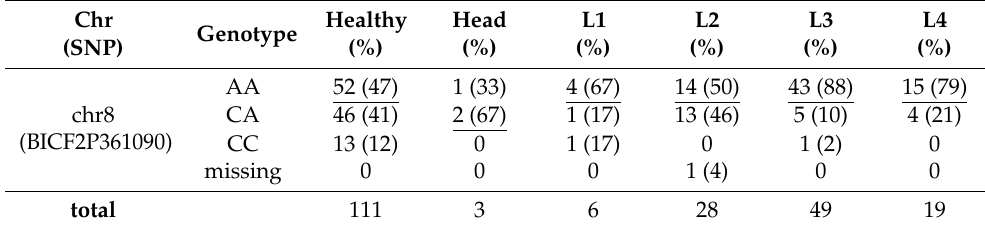
Table 4. Genotypes for the top SNP (chr8, BICF2P361090) from the QGWAS for each of the six phenotypic categories, with percentages shown in parentheses. The highest proportions in each phenotype group are underlined.